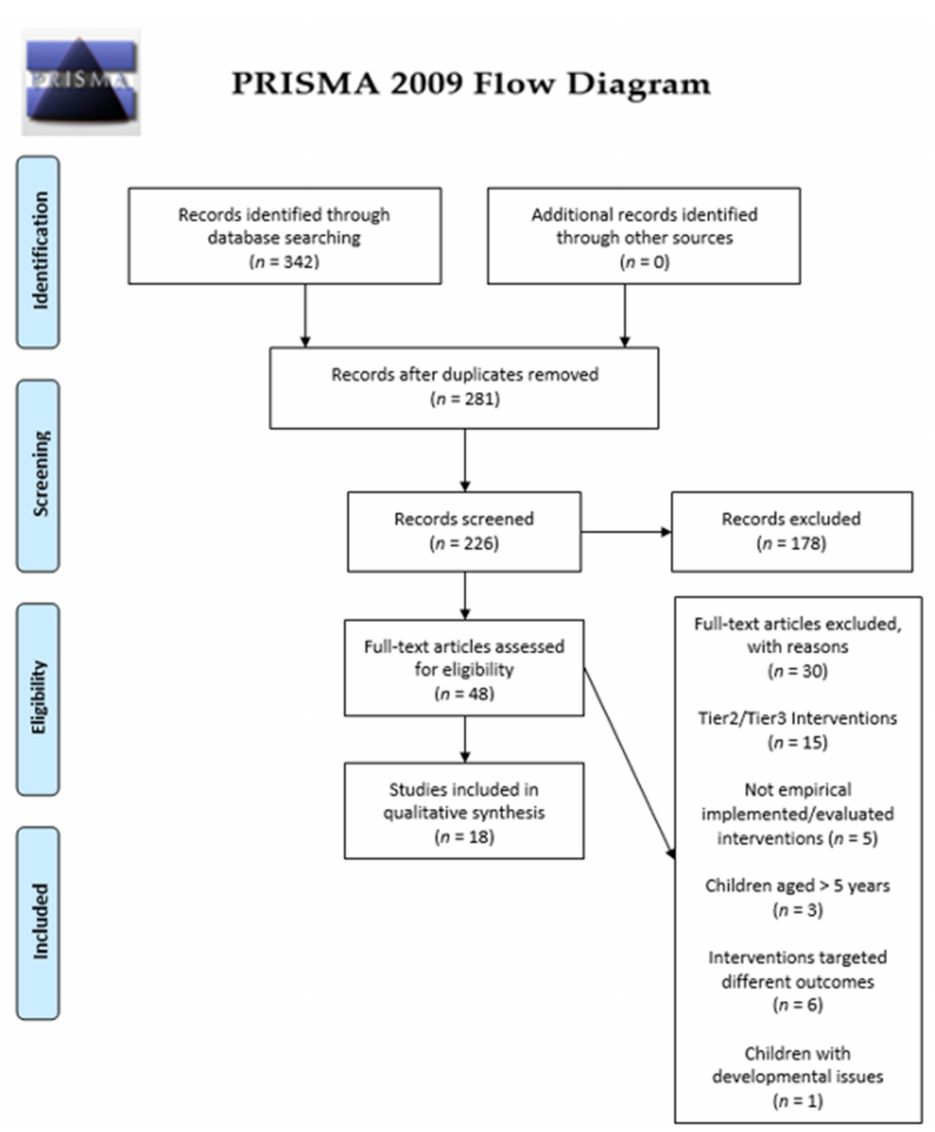
Figure 1. Flowchart for the systematic review